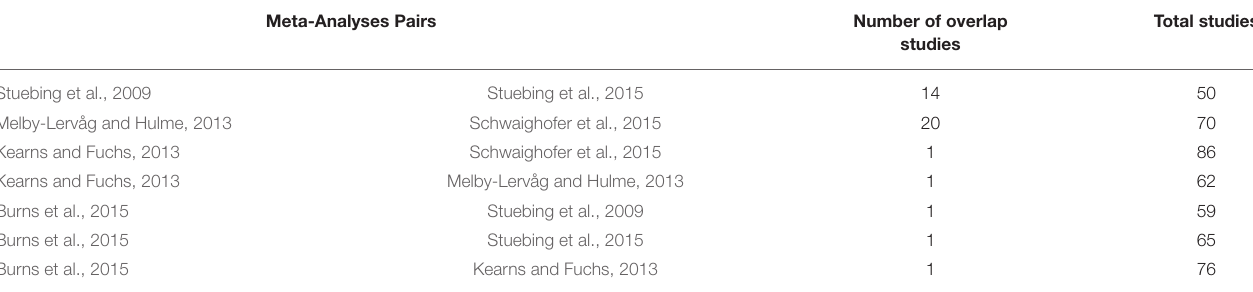
TABLE 8 | Overlap in